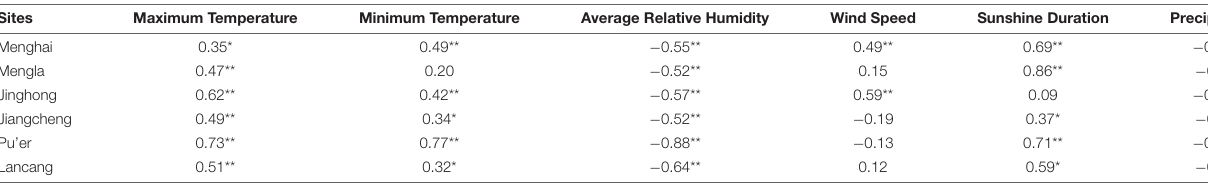
TABLE 4 | Linear correlation coefficient between ET 0 of each station and annual mean meteorological elements. Sites